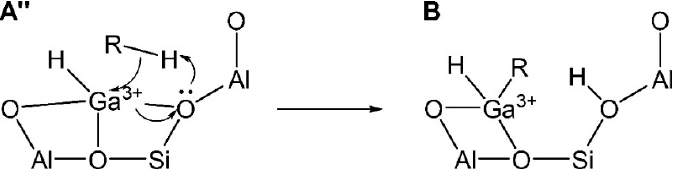
Figure 24. Alkane addition to the LBAS. Reprinted with permission from ref [73]. Copyright 2018 American Chemical Society. (Moritz W. Schreiber, 2018 [73]).